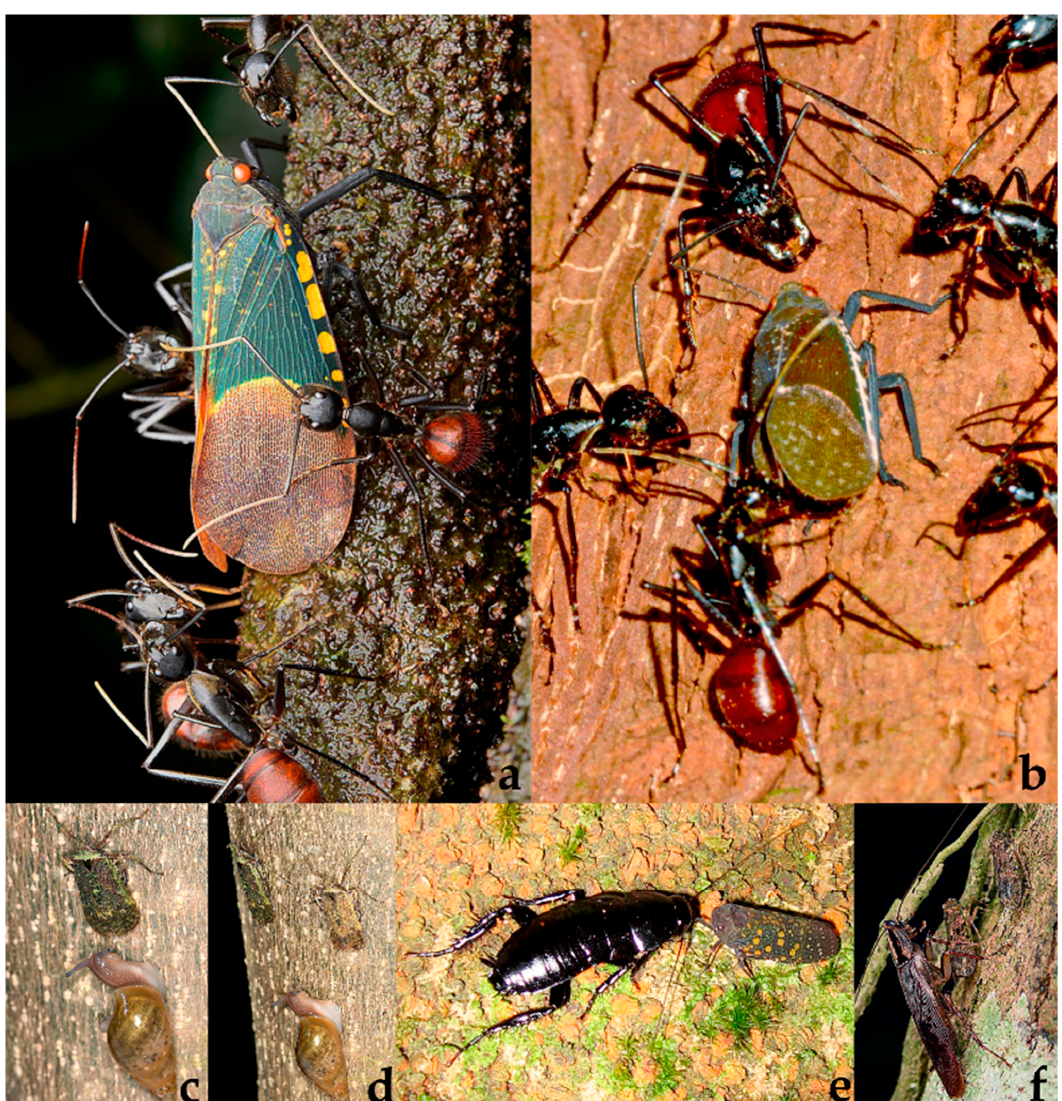
Figure 20. Fulgoridae: ( a ) Scamandra polychroma Gerstaecker, 1895 tended by Formicidae indet., Malaysia: Gunung Mulu National Park, 4°08 ′ 13.8 ″ N 114°53 ′ 30.5 ″ E, 25.11.2012, adult female on tree trunk, obs. C. Lee; ( b ) S. polychroma tended by Formicidae: Formicinae: Dinomyrmex gigas (Latreille, 1802), Malaysia: Borneo, Sarawak, Mulu National Park, 4°7 ′ 55 ″ N 114°55 ′ 8 ″ E, 8.07.2015, adult male on tree trunk, obs. A. Kang; ( c , d ) Villala canoi Goemans, 2005 tended by Gastropoda: Spiraxidae: Euglandina sp., Costa Rica: Puerto Viejo de Sarapiquí, La Selva Biological Station, 10°25 ′ N 84°0 ′ W, 02.02.2012, adult on tree trunk, obs. E. Holzer; ( e ) Poiocerinae indet. tended by Blattodea indet., Costa Rica: Bosque Eterno de Los Niños, 10°20 ′ 08.8 ″ N 84°44 ′ 00.6 ″ W, 14.05.2011, adult on tree trunk, obs. J. G. Phillips; ( f ) Fulgoridae indet. tended by Blattodea indet., Ecuador: Orellana, 0°28 ′ 00.9 ″ S 76°50 ′ 42.7 ″ W, 27.02.2018, adults on tree trunk, obs. C. Lee.